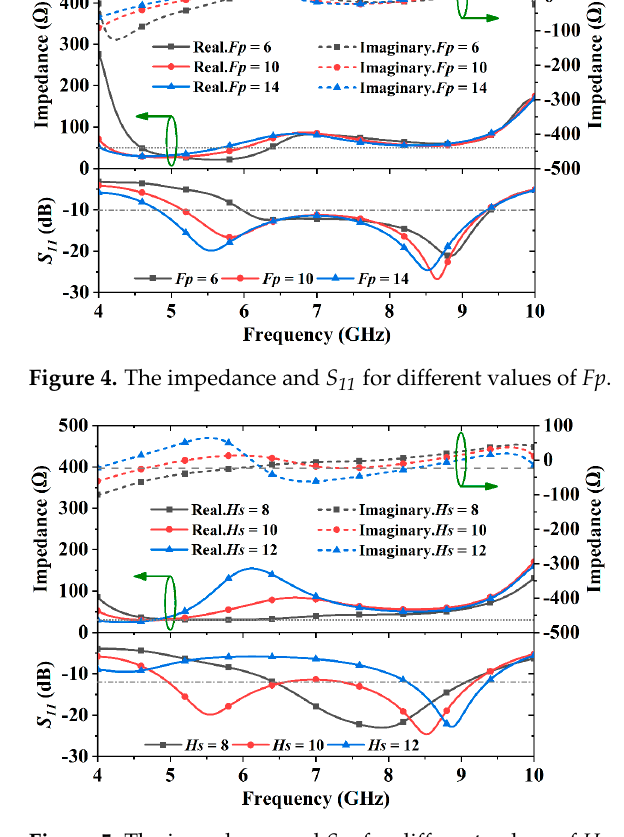
Figure 4. The impedance and S 11 for different values of Fp.